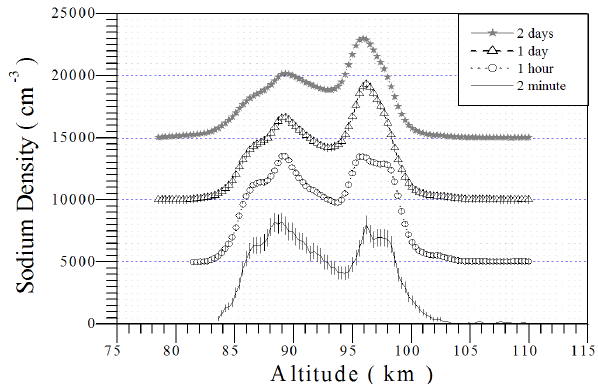
Fig. 2. Height profile of sodium density averaged over different time scales. The vertical bar represents the statistical error in the retrieved Na concentration. The profiles are vertically offset by 5 × 10 3